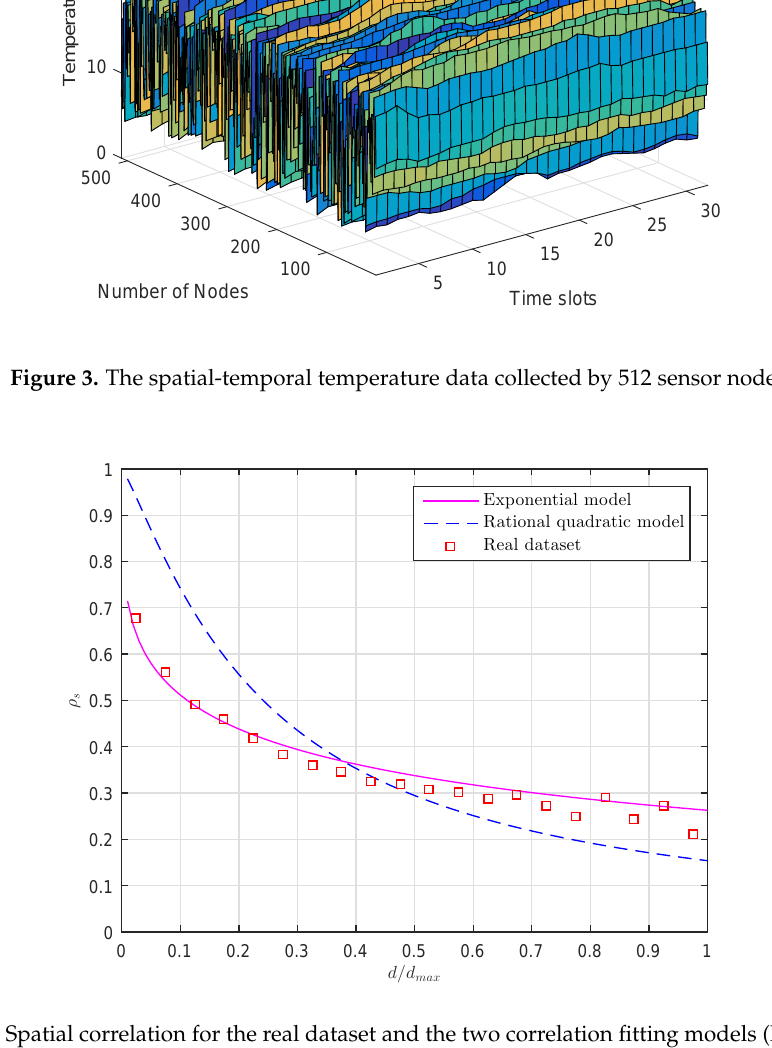
Figure 4. Spatial correlation for the real dataset and the two correlation fitting models (PE and